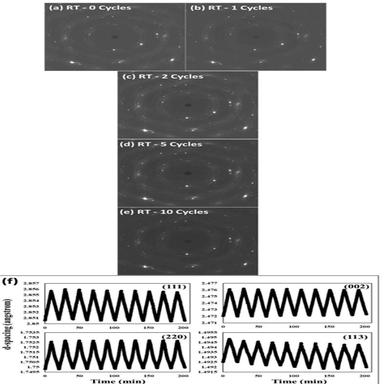
Full Debye-Scherrer diffraction rings of Pb-Ba at room temperature taken (a) before the first cycle and (b–e) after cycles 1, 2, 5, and 10. (f) Fitted peak position vs. time for the (111), (002), (220), and (113) reflections from the Pb-Ba sample over 10 thermal cycles.